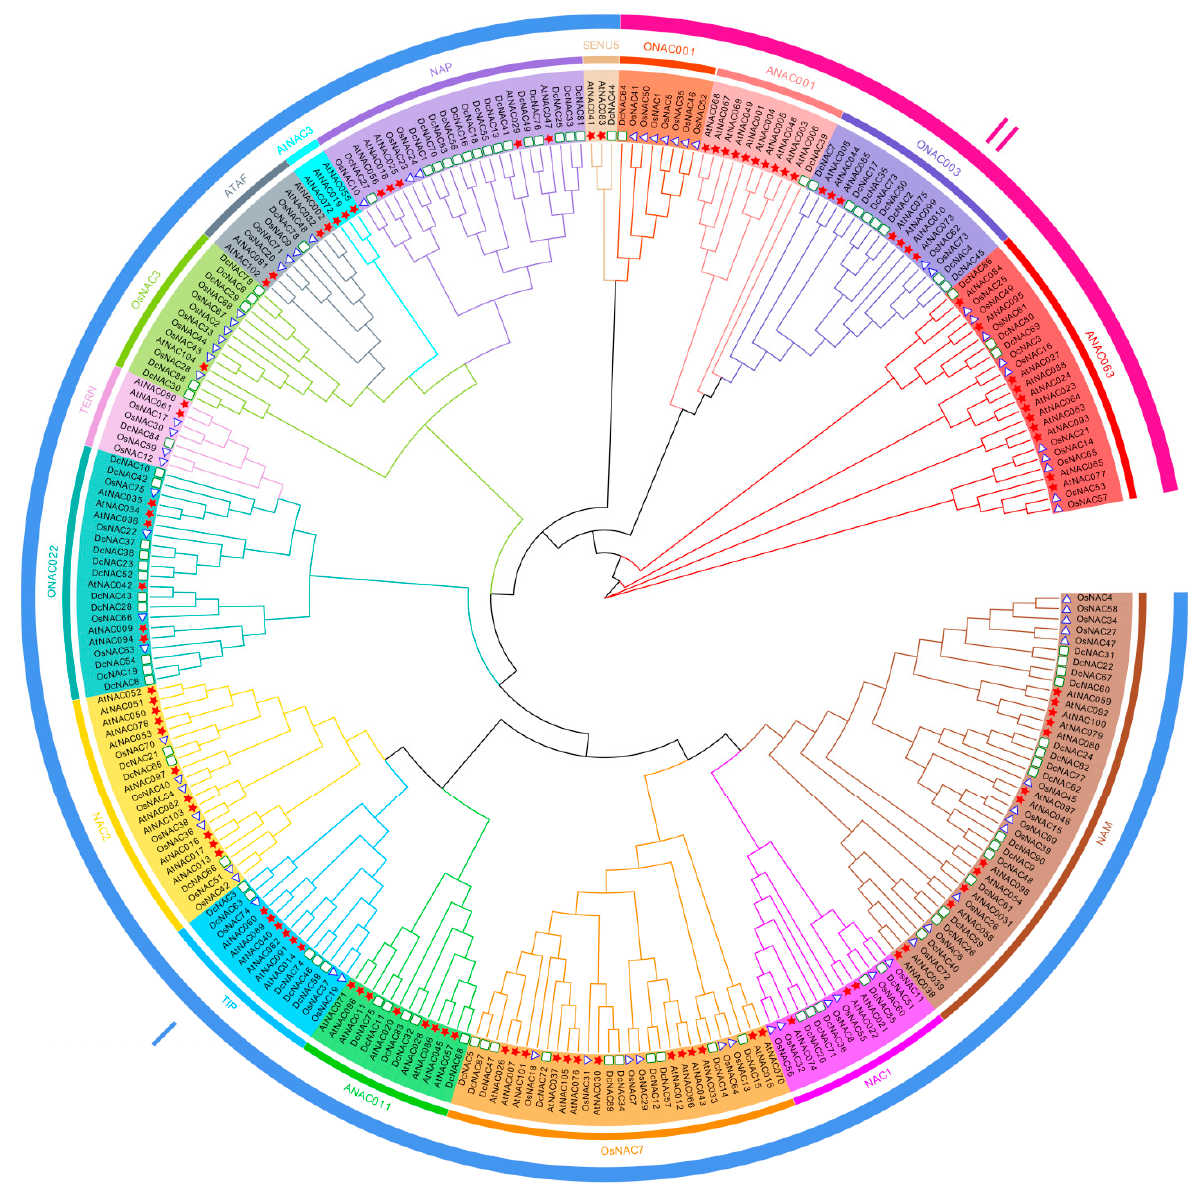
Figure 1. Phylogenetic analyses of NAC proteins from D. catenatum , Arabidopsis , and rice. A phylogenetic tree of NAC proteins was constructed using MEGA-X software (version 10.0.5). The NAC domains were classified into two large groups: Groups I and II. Group I was divided into 13 subgroups (TERN, ONAC022, SENU5, NAP, AtNAC3, ATAF, OsNAC3, NAC2, ANAC011, TIP, OsNAC7, NAC1, and NAM). Group II was divided into 4 subgroups (ANAC001, ONAC003, ONAC001, and ANAC063). The 17 subgroups are indicated with different colors. The red pentacles represent A. thaliana NACs (AtNACs), the green boxes represent D. catenatum NACs (DcNACs), and the blue triangles represent O. sativa NACs (OsNACs).